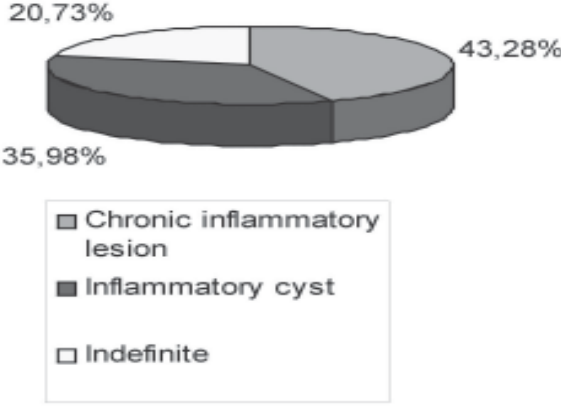
FIGURE 1 - Percentage of chronic inflammatory lesions evaluated by clinical radiographic examination (164